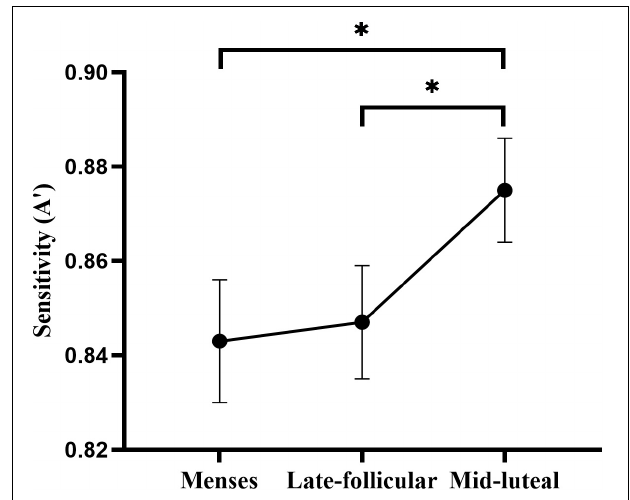
FIGURE 4 | The main effect of the menstrual cycle on the sensitivity measure of the divided attention task. ∗ indicates p <